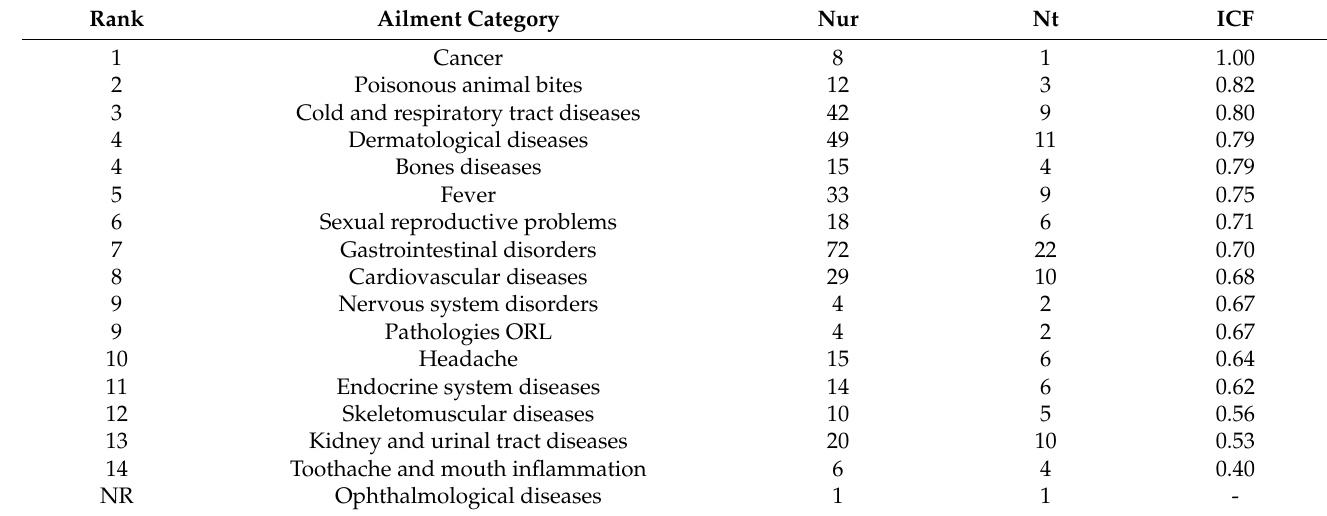
Table 3. Number of use report (Nur), ethnospecies (Nt), and values of the Informant Consensus Factor (ICF) per ailment category ordered from higher to lower ICF